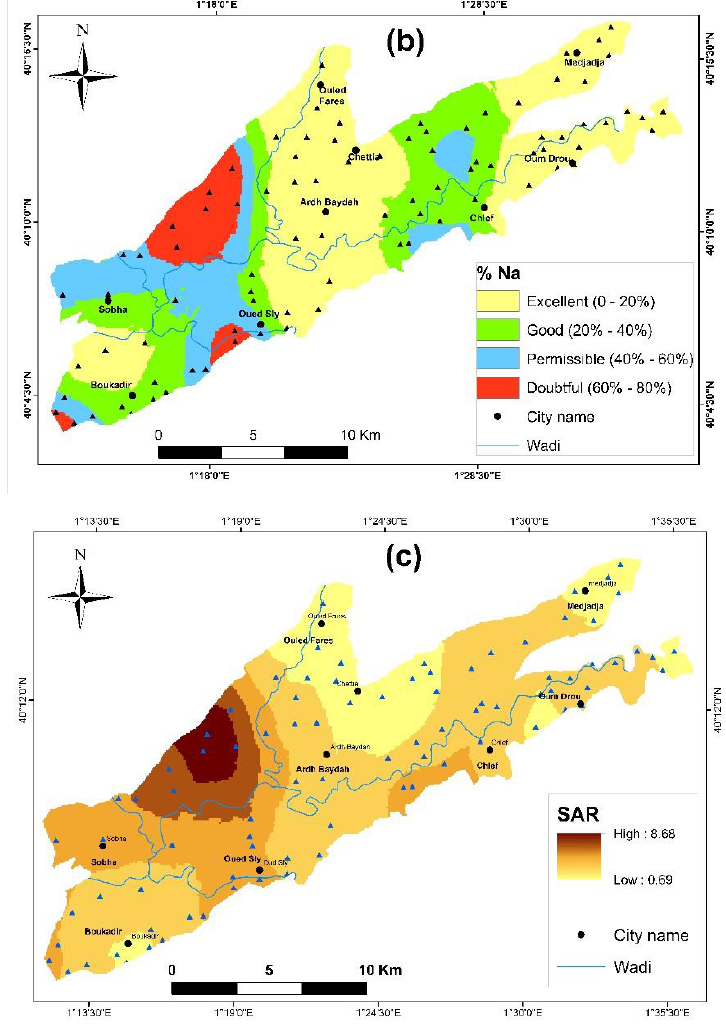
Figure 12. Spatial distribution of: ( a ) EC, ( b ) % Na, ( c ) SAR in WMCP. Combination of Factor Analysis and Geostatistical